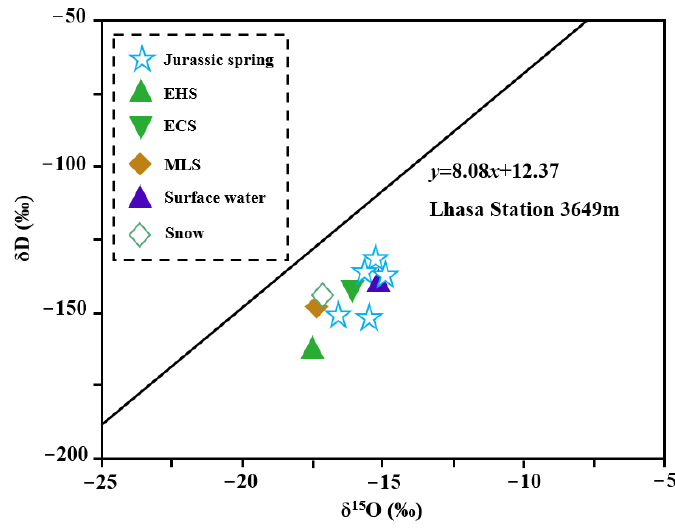
Figure 7. Relationship between D - 18 O of water samples in the study area. The D - 18 O isotopes of groundwater, river water, and snow water in the study area are distributed near the atmospheric precipitation line of Lhasa, indicating that their re- charge is directly or indirectly due to the infiltration of local atmospheric precipitation. The elevation effect of 18 O can be used to calculate the area of groundwater recharge that is replenished by atmospheric precipitation. According to the results of Yang Xiaoxin et al. in the adjacent areas, the elevation effect of precipitation calculated in the pre-mon- soon, monsoon, post-monsoon and western periods in this area is about −0 .14~ −0.21‰/10 0